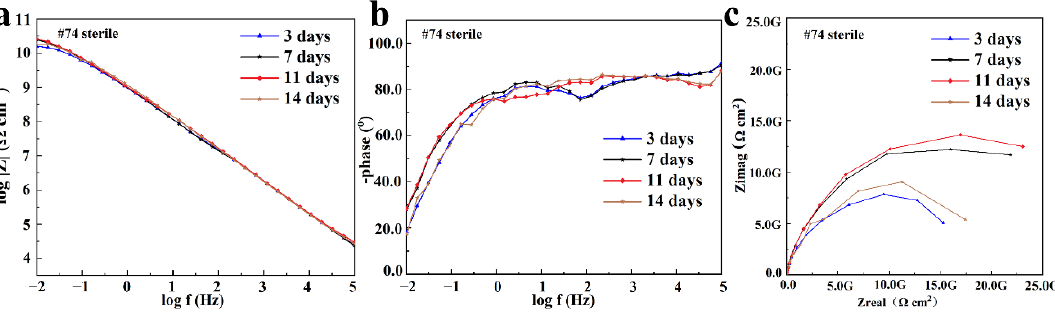
Figure 6. The Bode plot ( a ), phase plot ( b ), and Nyquist plot ( c ) of the #74 electrode after the immersion in a sterile liquid medium for 14 days.